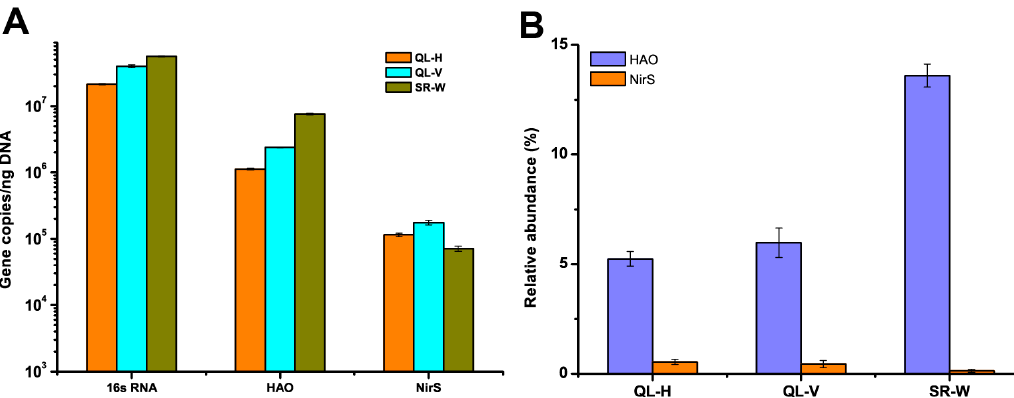
Figure 6. Abundance of bacterial 16S rRNA, HAO, and NirS genes in different sediment samples. (A) Copy numbers and (B) the relative abundance of HAO and NirS genes are represented as a percentage of their 16S rRNA gene abundance. Mean values and standard deviations were calculated according to the triplicate assay within a single qPCR setup.